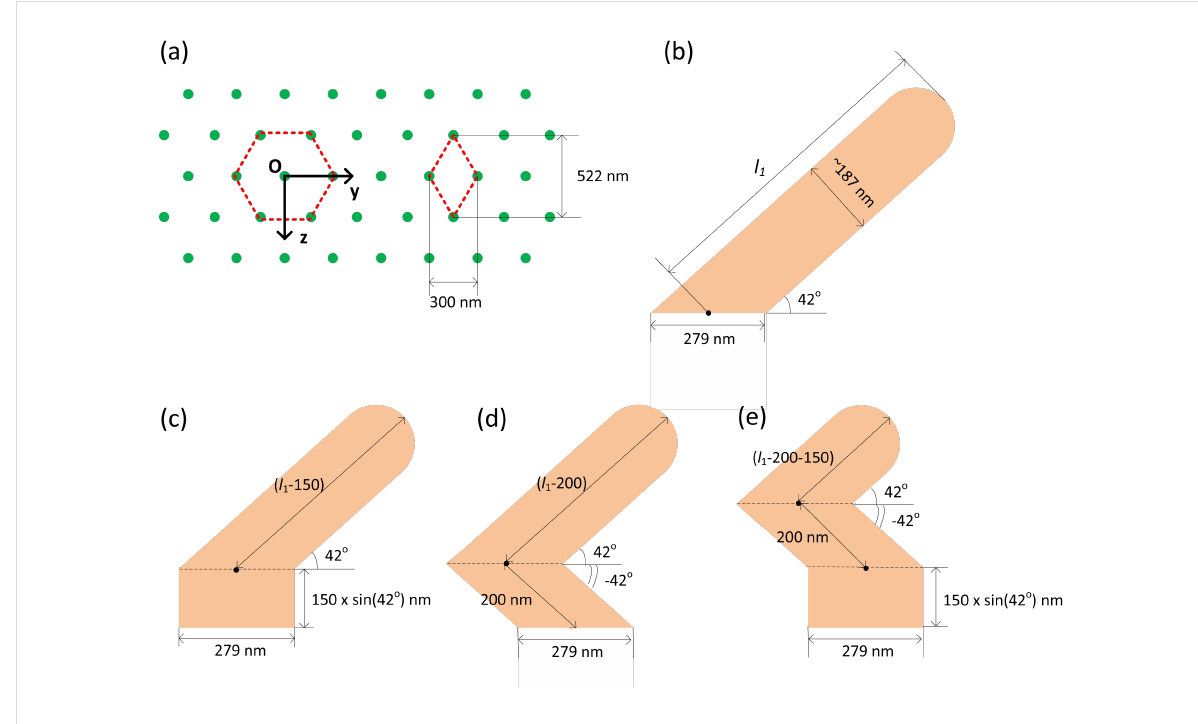
Figure 1: Schematic of the hexagonal pattern substrate (a) and four different target units: (b) S42; (c) S0:42; (d) S − 42:42; (e) S0: −